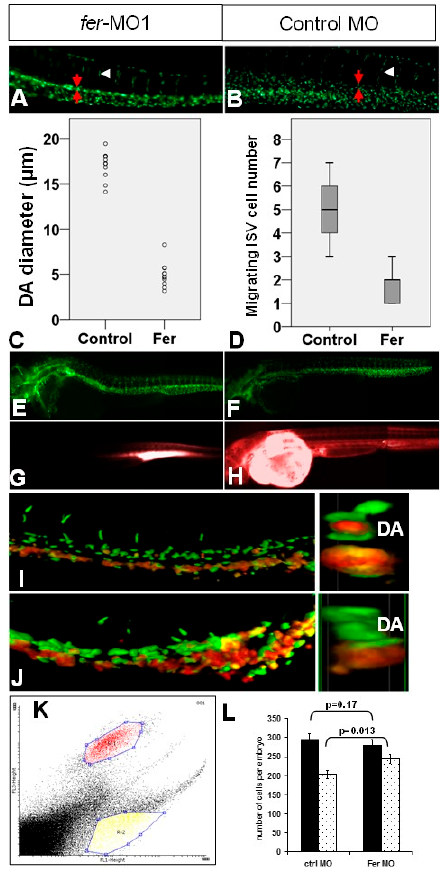
Figure 5. The loss of Fer kinase function resulted in vascular tubulogenesis defects. The loss of Fer kinase function decreased the diameter of the dorsal aorta ( A , C ) and resulted in fewer migrating cells into the ISV regions ( D ) at 30 somites (Control embryos ( B – D ). Rhodamine–Dextran injections into DA resulted in no visible dye circulation in Fer deficient embryos (( E ), fli1::nEGFP , ( G ), Rhodamine), when compared to control embryos (( F ), fli1::nEGFP , ( H ), Rhodamine). Confocal microscopy images demonstrated a concurrent loss of vasculature organization in the region of the DA and gain of hematopoietic precursors at 26 hpf (( I ), control MO, ( J ), fer -MO1). The right images in ( I , J ) are digital cross-sections, taken approximately midway through the image; z-stacks showed no gata1::dsRed signal in the region that should be the inner-DA. The FACS analysis showed a shift in the number of gata1::dsRed cells, along with a loss of vascular endothelial population (( K ), gated regions of non-overlapping, fli1a::nEGFP and gata1::dsRed cells, ( L ), quantitative plot showing differences in the cell population from ( K ) in the presence/absence of Fer kinase activity).